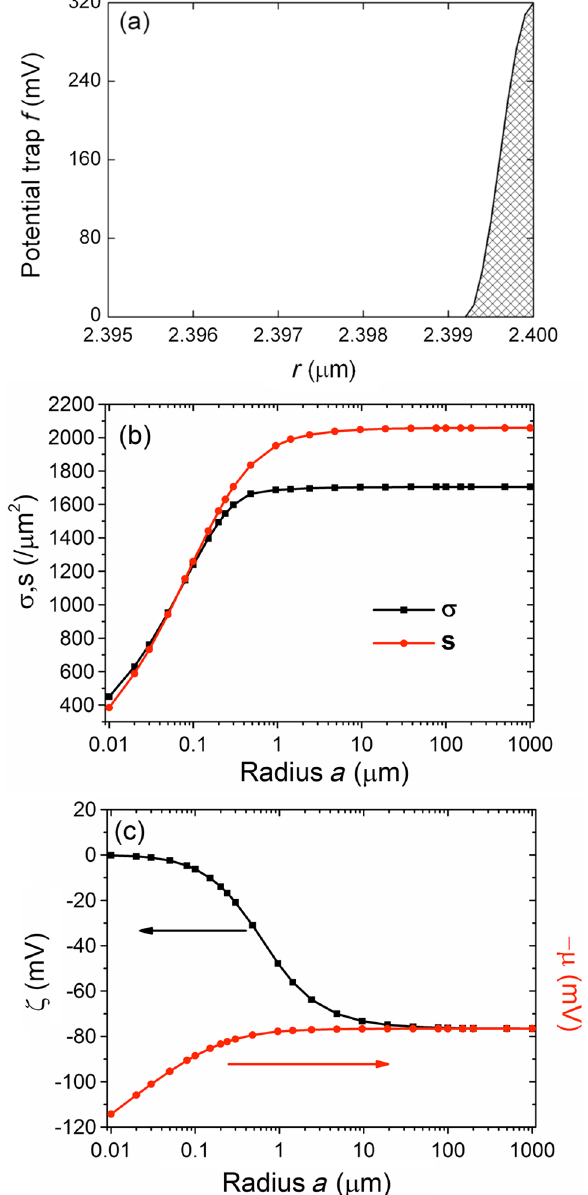
FIG. 2. Illustration of the interfacial potential trap and its consequences, with comparisons to the other models. (a) The functional form of the surface potential, given by Eq. (7). Here, the fluid-solid interface is at r ¼ 2 . 4 μ m. (b) The self-consis- tently determined surface charge density σ as defined by Eq. (11), plotted as a function of a (red symbols and curve). The black symbols and the fitting curve are for s , defined as the density of the negative ions integrated over the width of the surface potential trap shown in (a). It is seen that s > σ because part of s is captured from the bulk. (c) Negative of the chemical potential, − μ (right scale, red symbols and fitting curve), determined self-consistently with σ through Eqs. (10b) and (11), plotted as a function a . The black symbols and fitting curve denote the zeta potential, ζ (left scale), as defined by Eq. (15). It is seen that the two quantities agree closely for a > 10 μ m but deviate from each other below